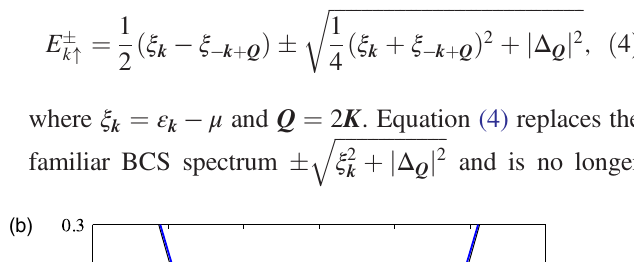
− μ Þ . Turning on Δ 100 meV with k 1 . 0 in Eq. (3) splits the bands 0 ¼ 0 ¼ (cid:2) 2 K